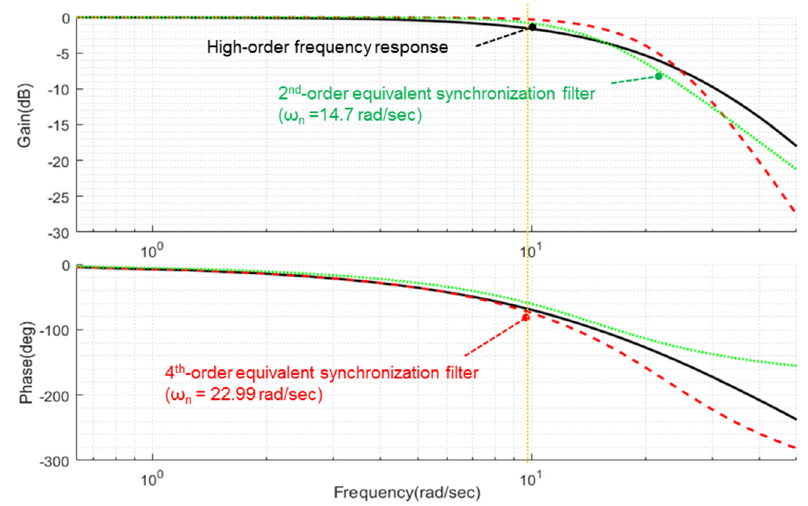
Figure 4. Bode plot on high-order frequency response and 4th-order equivalent synchronization filter when the control surface command is fed back before the actuator dynamics.